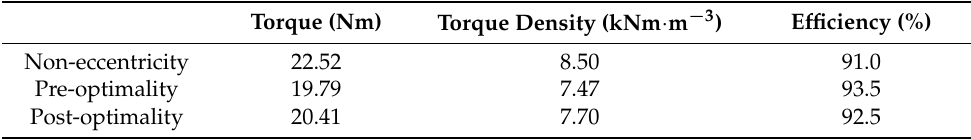
Table 2. Comparison results of torque density and efficiency at rated load.